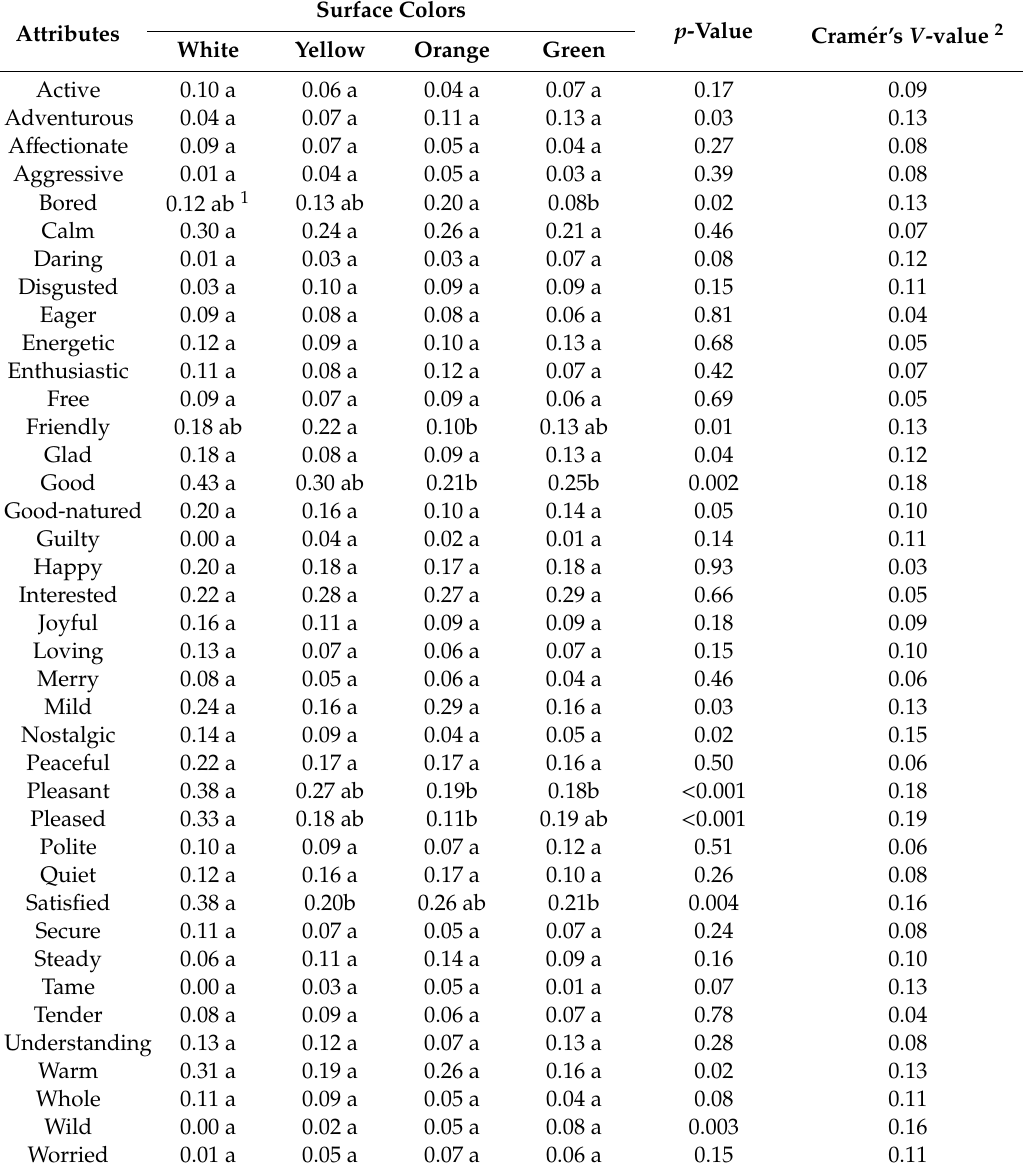
Table 3. A contingency table of the proportions of selection by 98 participants for individual emotional attributes among the four cooked-rice samples with di ff erent surface